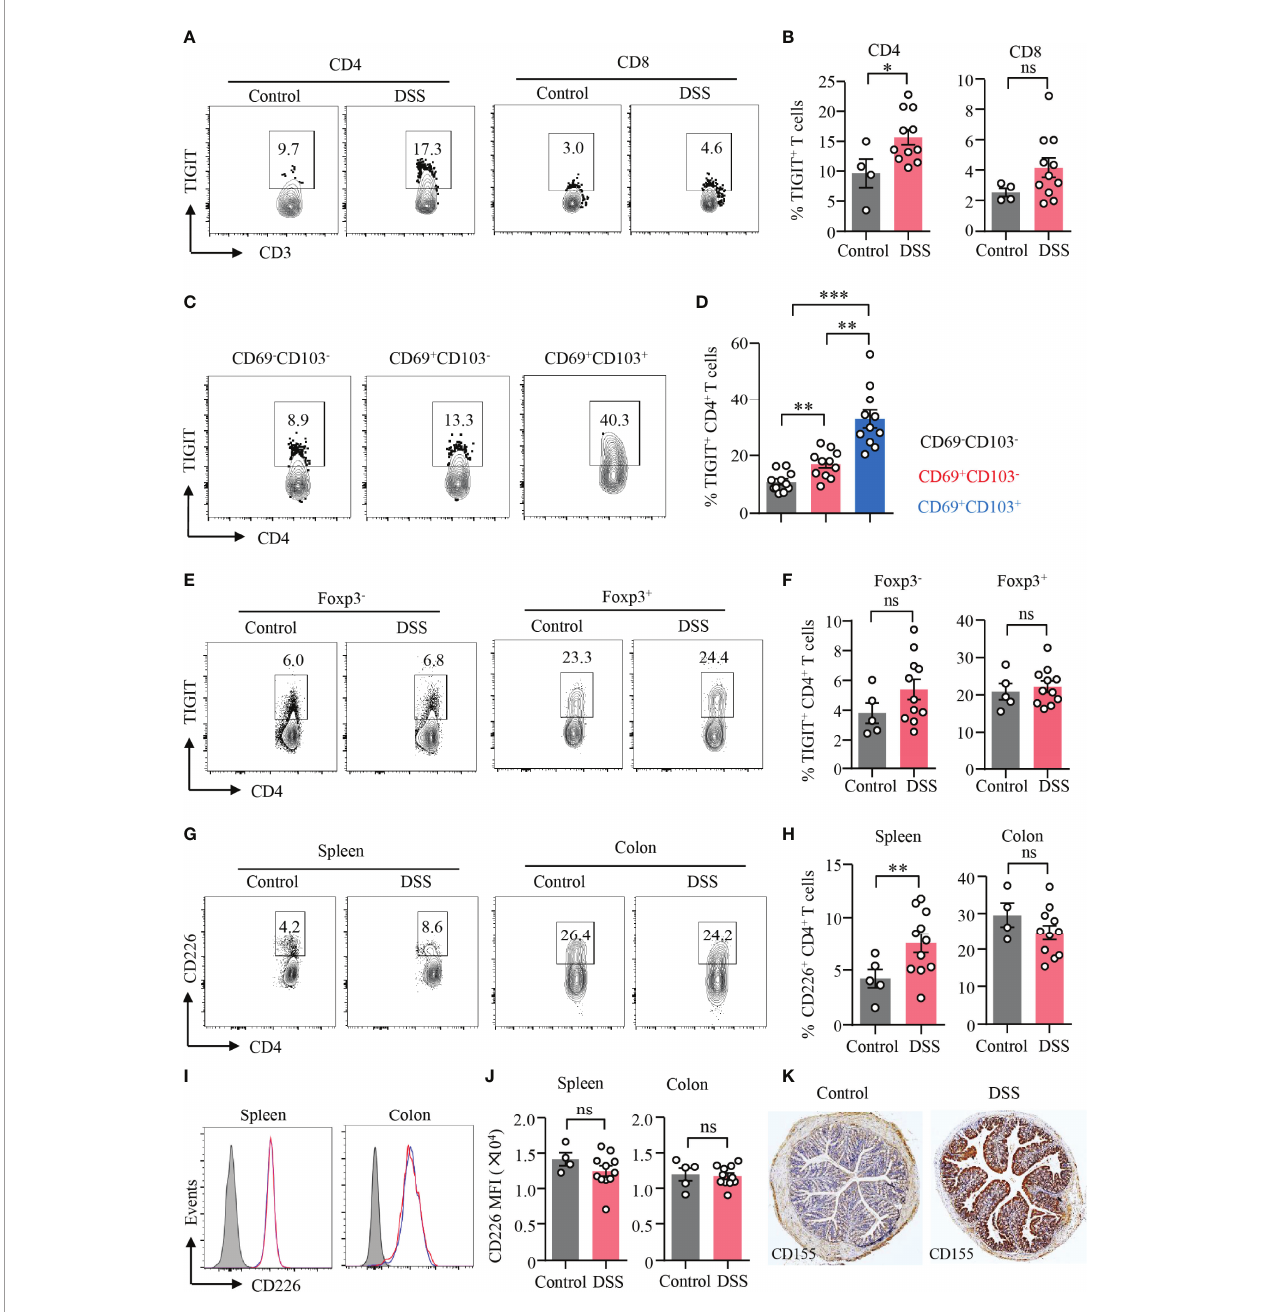
FIGURE 3 | TIGIT expression in CD4 + T cells was increased during DSS-induced colitis. DSS-induced colitis was established as described in Figure 1 . Single-cell suspension of the spleen or LPMC was prepared as described in Figure 1 . (A) TIGIT expression in CD4 + and CD8 + T cells from LPMC was measured by fl ow cytometry. Representative counter plots were shown. (B) Frequencies of TIGIT + CD4 + T cells and TIGIT + CD8 + T cells from LPL were summarized. (C) Representative counter plots for TIGIT expression in CD4 + CD69 − CD103 − T cells, CD4 + CD69 + CD103 − T cells, or CD4 + CD69 + CD103 + T cells. (D) Frequencies of TIGIT + cells among CD4 + CD69 − CD103 − T cells, CD4 + CD69 + CD103 − T cells, or CD4 + CD69 + CD103 + T-cell subsets in DSS-induced colitis. (E) TIGIT expression in CD4 + FoxP3 + and CD4 + FoxP3 − T cells in the spleen was measured by fl ow cytometry. Representative counter plots were shown. (F) Frequencies of TIGIT + Foxp3 + CD4 + T cells and Foxp3 − CD4 + T cells were summarized. (G – J) CD226 expression in CD4 + and CD8 + T cells from LPMC or spleen of mice with or without DSS-induced colitis was measured by fl ow cytometry. (G) Representative counter plots of CD226 expression in CD4 + T cells from the spleen or LPMC of mice with or without DSS-induced colitis. (H) Frequencies of CD226 + CD4 + T cells were summarized. (I) Representative histograms of CD226 expression in CD8 + T cells from the spleen or LPMC of mice with or without DSS-induced colitis. (J) Mean fl uorescence intensity (MFI) of CD226 expression in CD8 + T cells. (K) Colon sections from mice with or without DSS- induced colitis were stained with antibody against CD155. Representative images of CD155 staining by immunohistochemistry were shown. Original magni fi cation: ×4. Data are means ± SEM. * p < 0.05, ** p < 0.01, *** p < 0.001, by Student ’ s t -test. ns, not signi fi